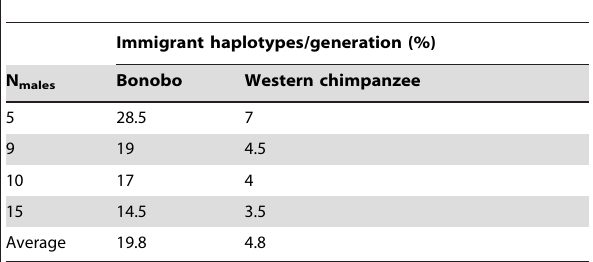
Table 3. Estimated rates of male–mediated gene flow in bonobos and western chimpanzees for different male group